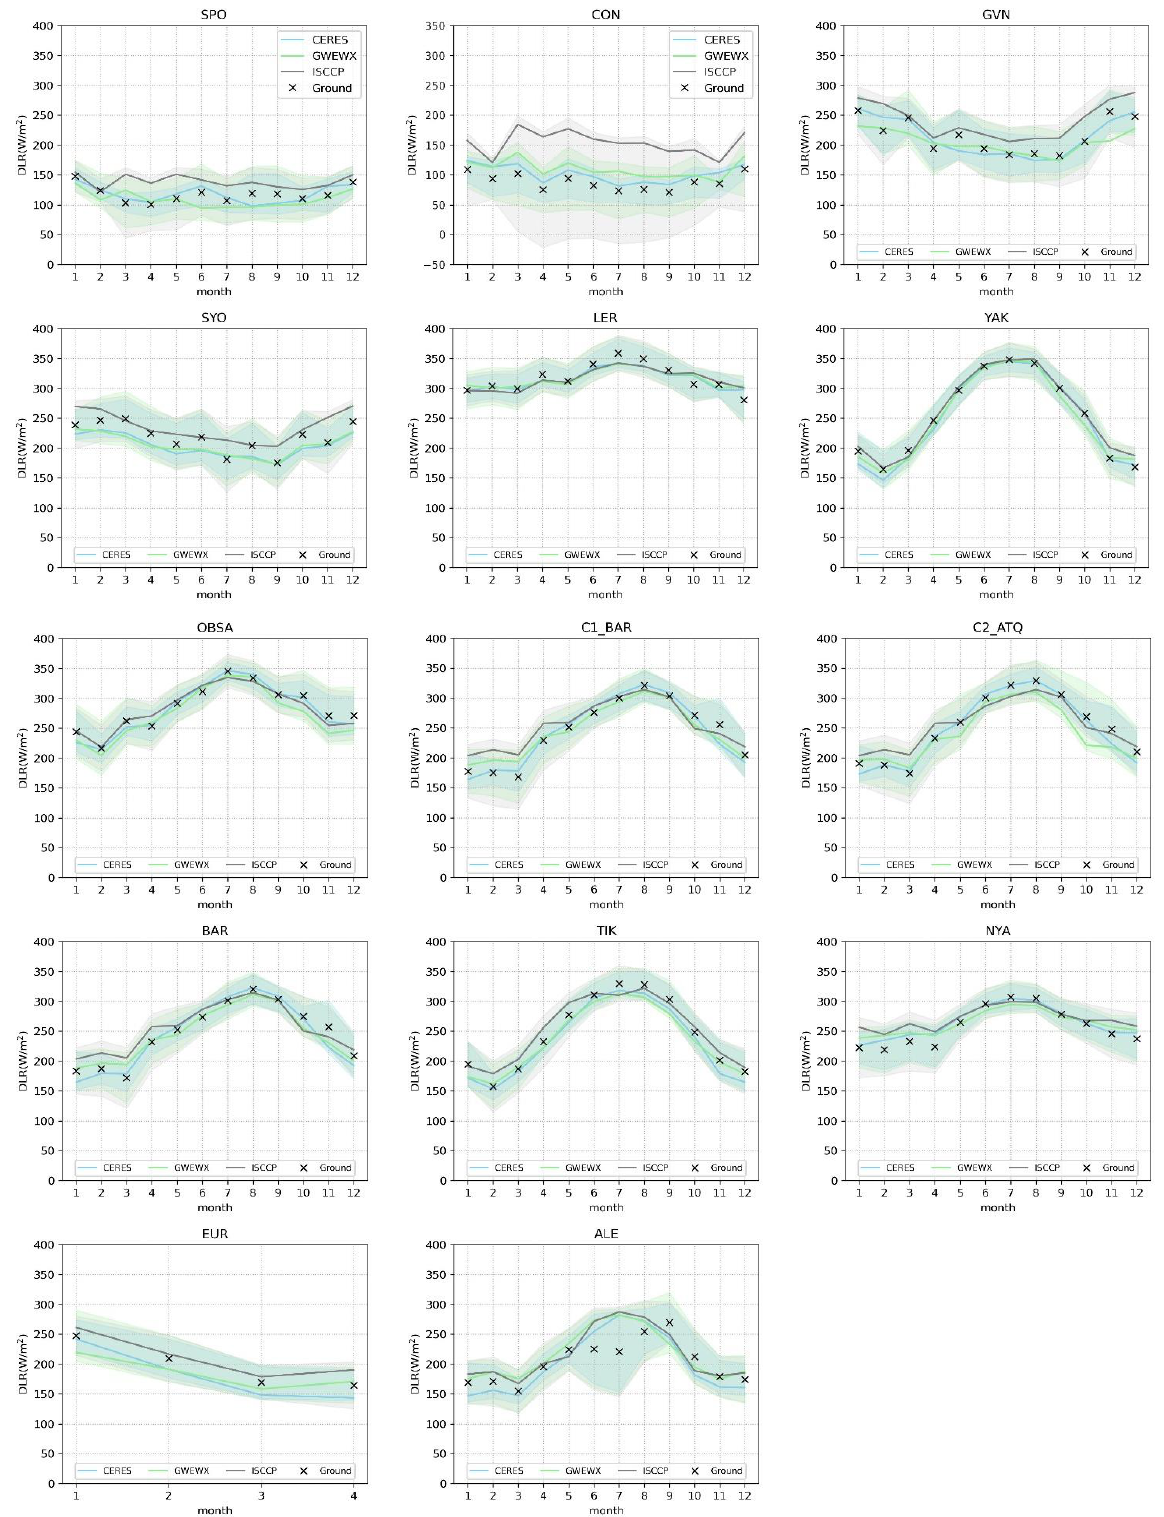
from each product.